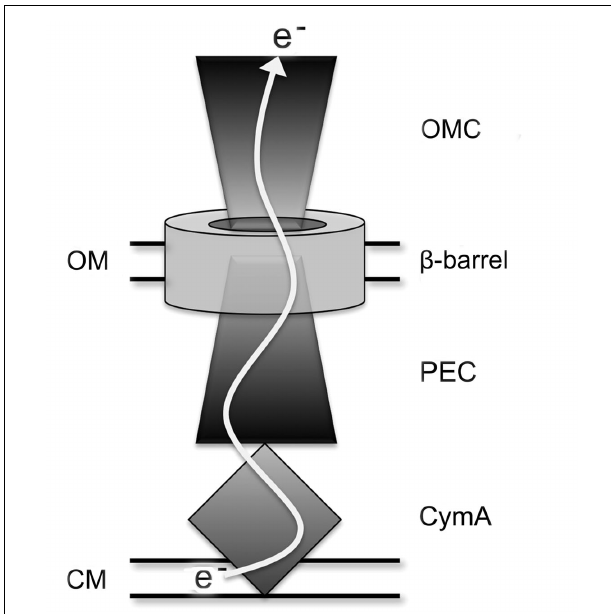
FIGURE 1 | Schematic of extracellular electron transfer pathway in S. oneidensis . OMC represents outer-membrane cytochrome paralogs of MtrC, β -barrel represents MtrB paralogs, and PEC represents periplasmic electron carrier paralogs of MtrA. OM and CM represent OM and CM,